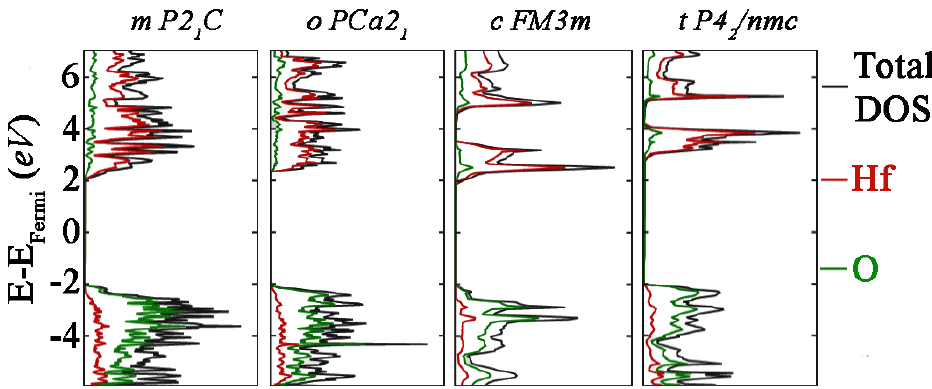
Figure 4. partial and total DOS of HfO 2 polymorphs investigated. The m- P2 1 c , o- PCa2 1 , c- FM3m , and t- P4 2 /nmc are reported to note the differences between the polymorphs.